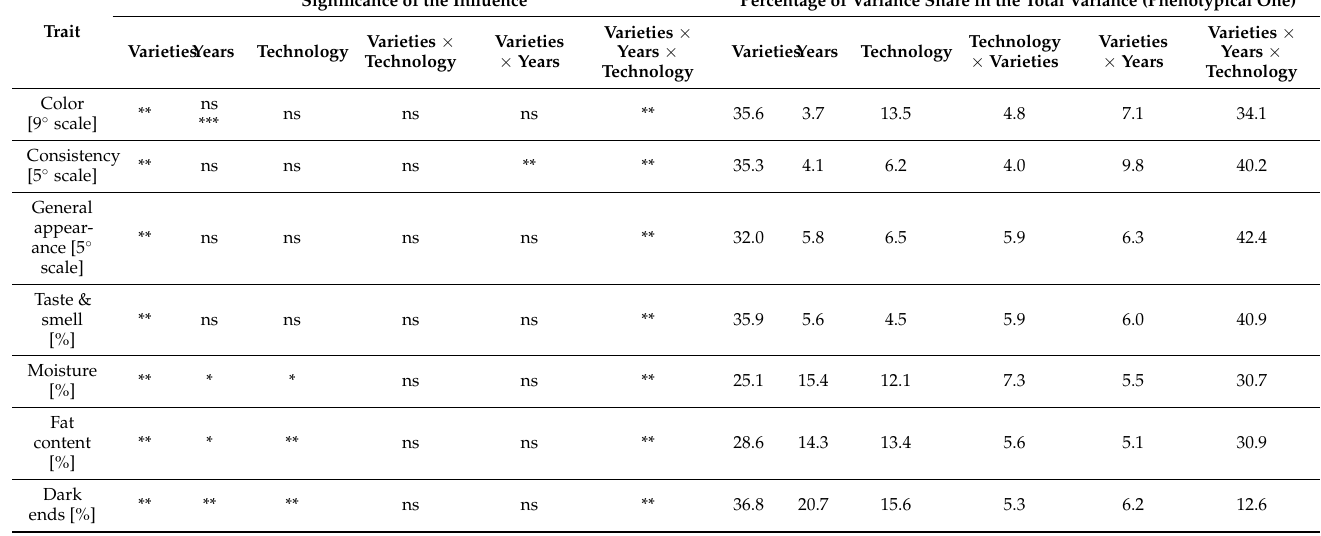
Table 6. The influence of varieties, technology, and years, and their interaction on color, consistency, appearance, taste and smell, moisture, fat content, and dark ends of FF and the percentages of participation of varieties, technology, years, and the interaction of cultivar x years in total variance.